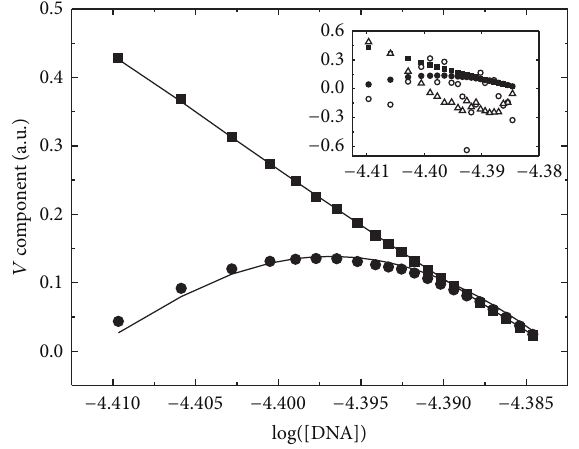
Figure 3: 𝑉 component amplitude as a function of the total DNA concentration. Data were generated from the SVD matrix of the ActD-DNA titration data. The squares show the first 𝑉 component values, and circles represent the second-component amplitudes. The first four 𝑉 component amplitudes are shown in the inset, and the results generated from the F matrix were adjusted to the experimental data using our SVD analysis routine and are shown by the solid lines.